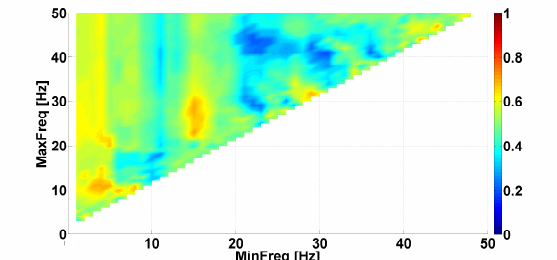
Figure 3. Example of Phase-difference area under the ROC curve (AUC) diagram. This AUC diagram is a kind of Frequency AUC diagram, that is, the AUC diagram indicates the AUC values corresponding to different frequency ranges. Parkinson’s disease (PD) and essential tremor (ET) patients are compared, namely, left arms with hyperkinetic movements are analyzed. The abscissa axis is the lower bound of the frequency range; the ordinate axis is the upper bound of the frequency